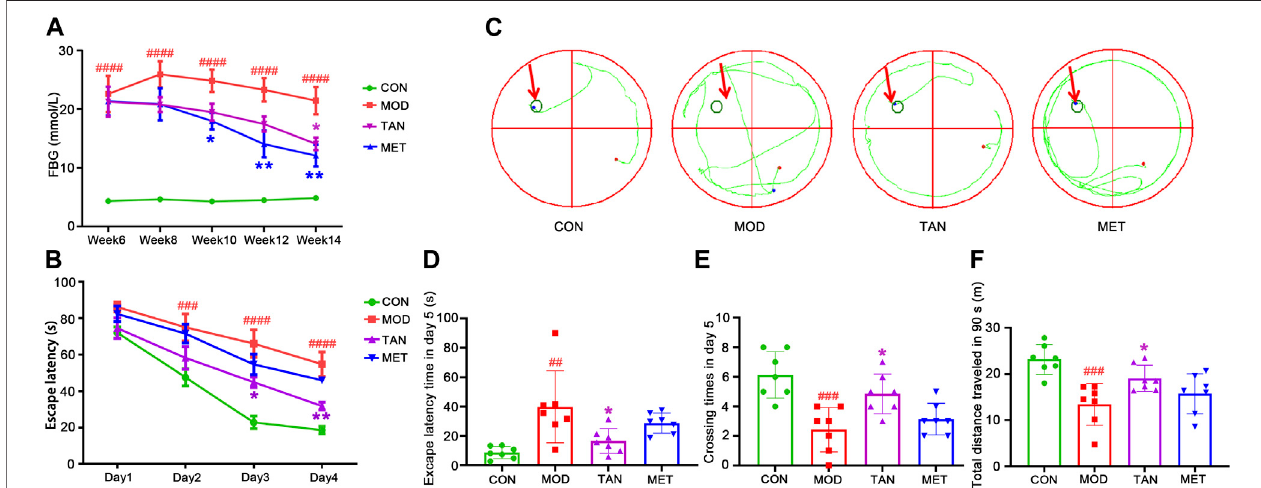
FIGURE1| Thechangesinblood glucose level and cognitive function inresponsetoTAN treatment ( n =7ratsper group). (A) TAN time-dependentlyreversed the HFD and STZ-induced high blood glucose level(mmol/L)in diabetic ratsfrom week 6toweek 14. #### p < 0.0001vs . CON groupat the same time point. * p < 0.05, ** p < 0.01vs . MODgroupatthesametimepointasanalysedbytwo-wayrepeatedmeasuresANOVAanalysis. (B) TANtreatmentexhibitedtime-dependenteffectinreducing escape latency time (s) in the training phase from day 1 to day 4. The escape latency time was compared among the groups at the same time point by two-way repeated measures ANOVA. #### p < 0.0001 vs . CON group at the same time point. * p < 0.05, ** p < 0.01 vs . MOD group at the same time point. (C) Trajectory chart (green color) represents occupancy across the entire 90 s trial in the probe test (day 5). The green circles on the northwest platform refer to the target platform. (D) Statistical analysis by one-way ANOVA showed that TAN treatment signi fi cantly increased the time spent in the target quadrant and (E) platform-crossing times compared with the MOD group (F) TAN signi fi cantly restored the total distance travelled in 90 s (m) compared with the MOD group. Results are shown as the mean ± standard deviation. ## p < 0.01, ### p < 0.001 vs . CON group and * p < 0.05, ** p < 0.01 vs. MOD group. TAN, tanshinone IIA; CON, control; MOD,